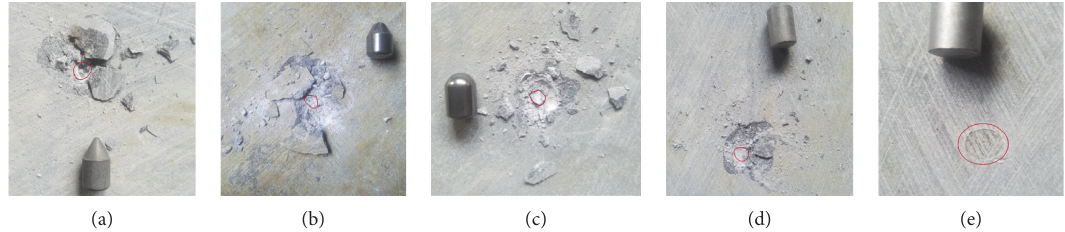
Figure 8: Rock fragmentation under different indenter shapes: (a) cusp-conical, (b) warhead, (c) hemispherical, (d) spherical-arc, and (e) flat-top.